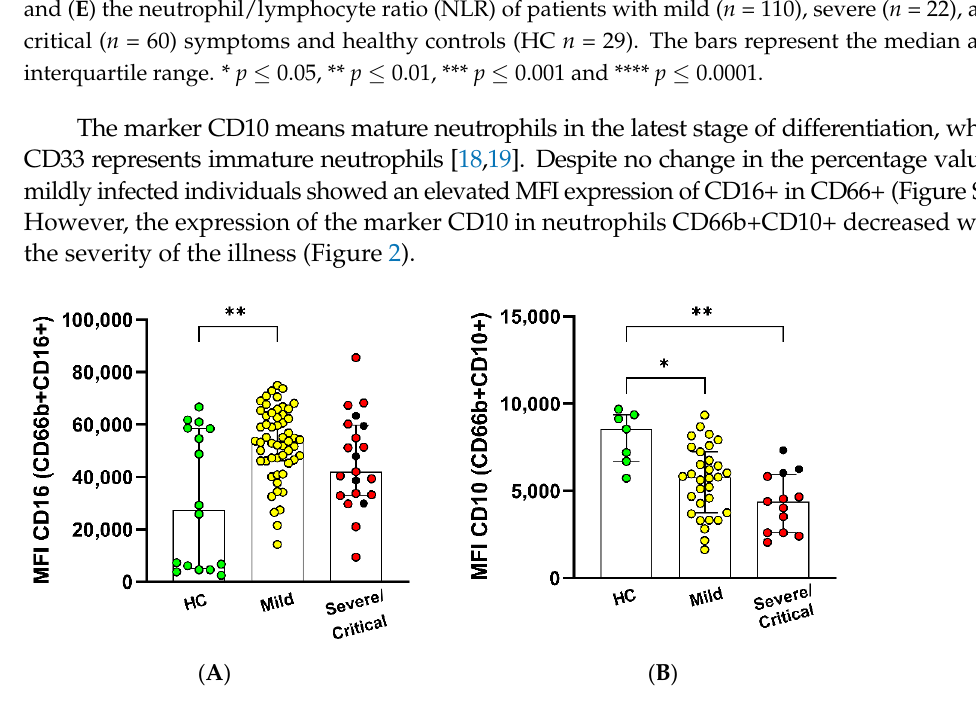
Figure 2. Immature neutrophil profile with COVID-19 infection severity. CD66b+ expression from patients with mild ( n = 55), severe ( n = 5), and critical ( n = 16) symptoms and healthy controls (HC n = 16) In ( A ) CD16 and ( B ) CD10, assessed by flow cytometry are shown as MFI (median of fluorescence intensity). The bars represent the median and interquartile range. * p ≤ 0 .05, ** p ≤ 0 .01, *** p ≤ 0 .001 and **** p ≤ 0 .0001.